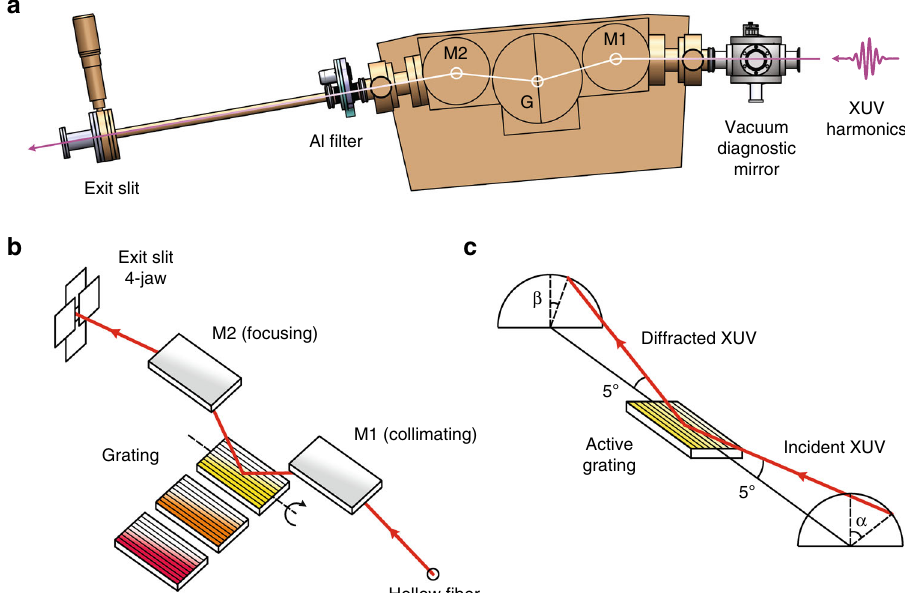
Fig. 2 XUV monochromator. a Schematic of XUV monochromator in our setup. M1 and M2 refer to the collimating and focusing toroidal gold mirrors with respect to the grating G. b Optical layout inside the XUV monochromator. Three gratings with different groove density and blaze angle are placed inside the monochromator. A sliding mechanism inside the vacuum provides easy access to select the active grating, highlighted in yellow. c Light diffraction by an off-plane mounted (active) grating that forms cones with half-angle